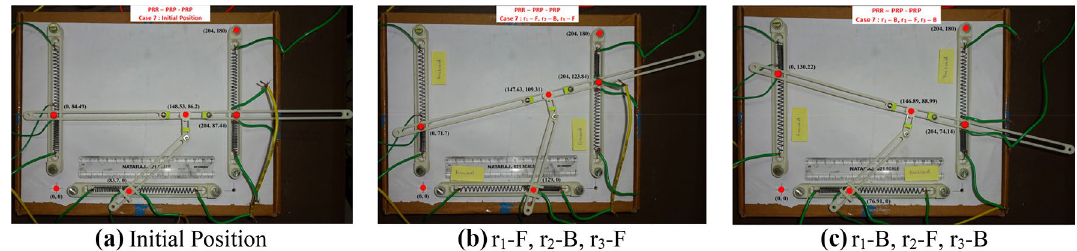
Fig. 14 Actuation of SMA springs of C9 manipulator (Condition